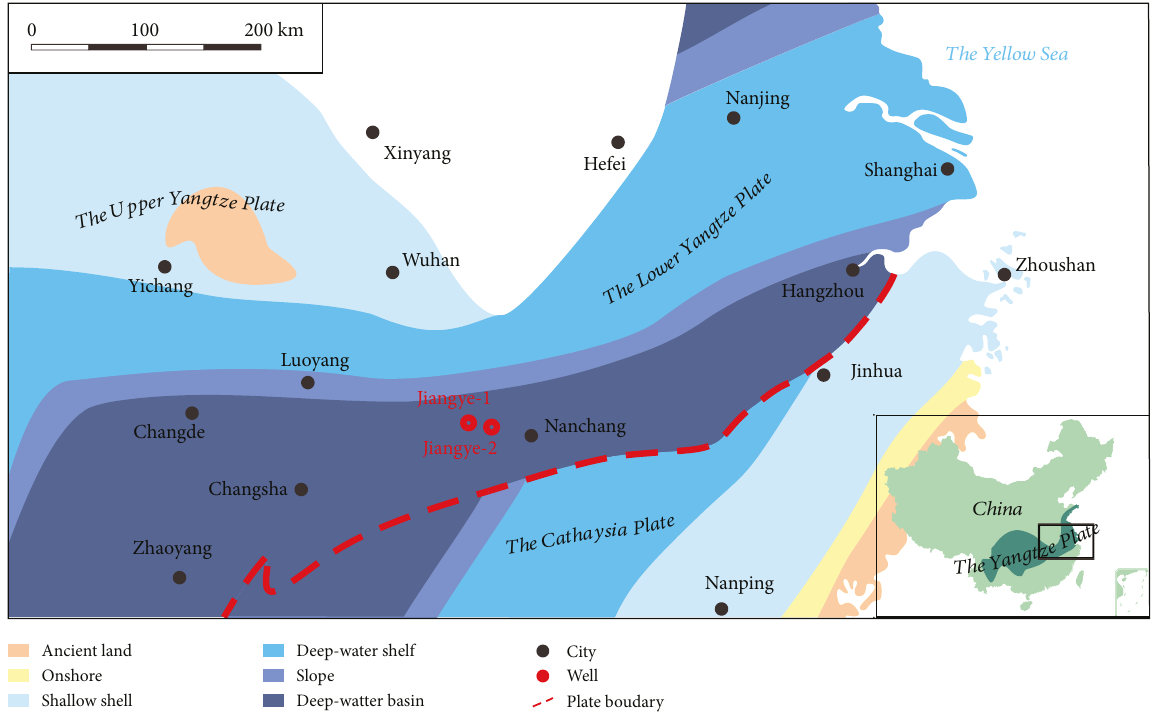
Figure 2: A map of the regional sedimentary characteristics of the lower Cambrian in the Lower Yangtze, South China.